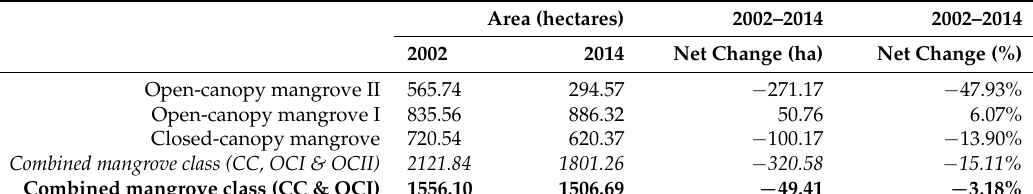
Table 8. Aerial and net changes in each mangrove class within the study area between 2002 and 2014. These figures were combined to give aerial and net changes of all mangroves (closed-canopy, open-canopy I and open-canopy II) and only for closed-canopy and open-canopy I.